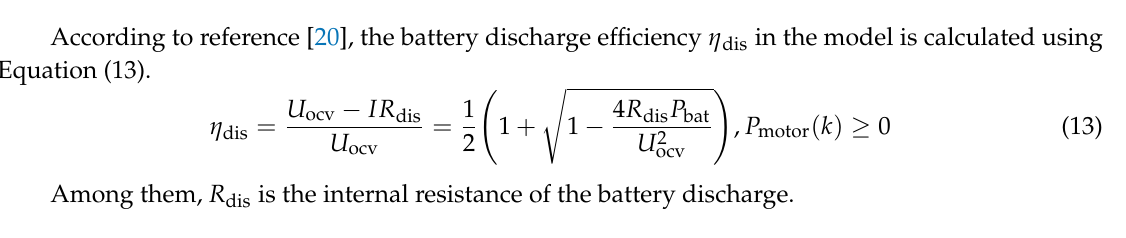
Figure 3. Battery equivalent circuit simplified model.